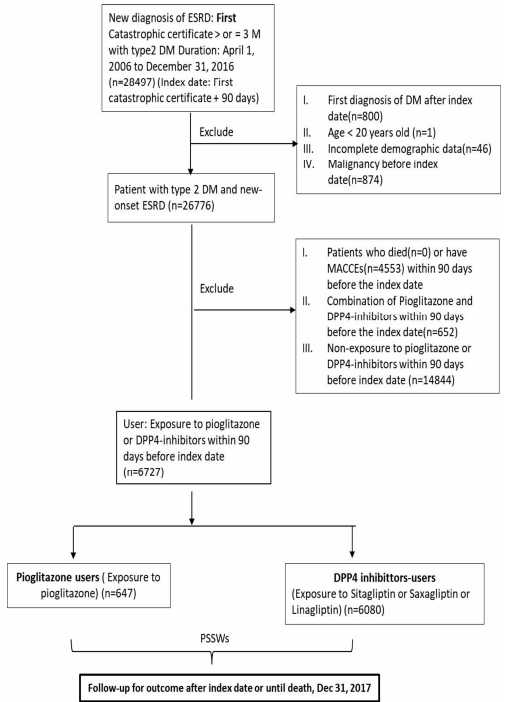
Figure 1. Flow chart of study patient enrollment. DM, diabetes mellitus; DPP4-inhibitor, Dipeptidyl peptidase 4 inhibitor; ESRD, end stage renal disease; MACCEs, major adverse cardiac cerebrovascular events.